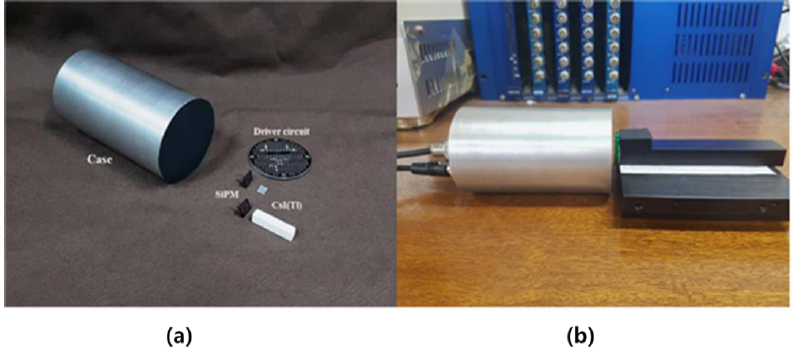
Figure 26. Beta/gamma detector connected with CsI(Tl), SiPM sensor ( a ); driving circuit ( b ) [59]. In 2019, KAIST from the Republic of Korea optimized the thickness of the scintillator by manufacturing a Phoswich-type detector that can simultaneously measure alpha and beta radioactive contamination in order to develop a technology that can quickly and ef- ficiently measure the radioactive contamination of a large area. As the scintillator of the Phoswich detector, ZnS:Ag(EJ-600) for alpha, a plastic scintillator (EJ-212) for beta was selected in consideration of detection efficiency and decay time [Figure 27]. Pulse shape